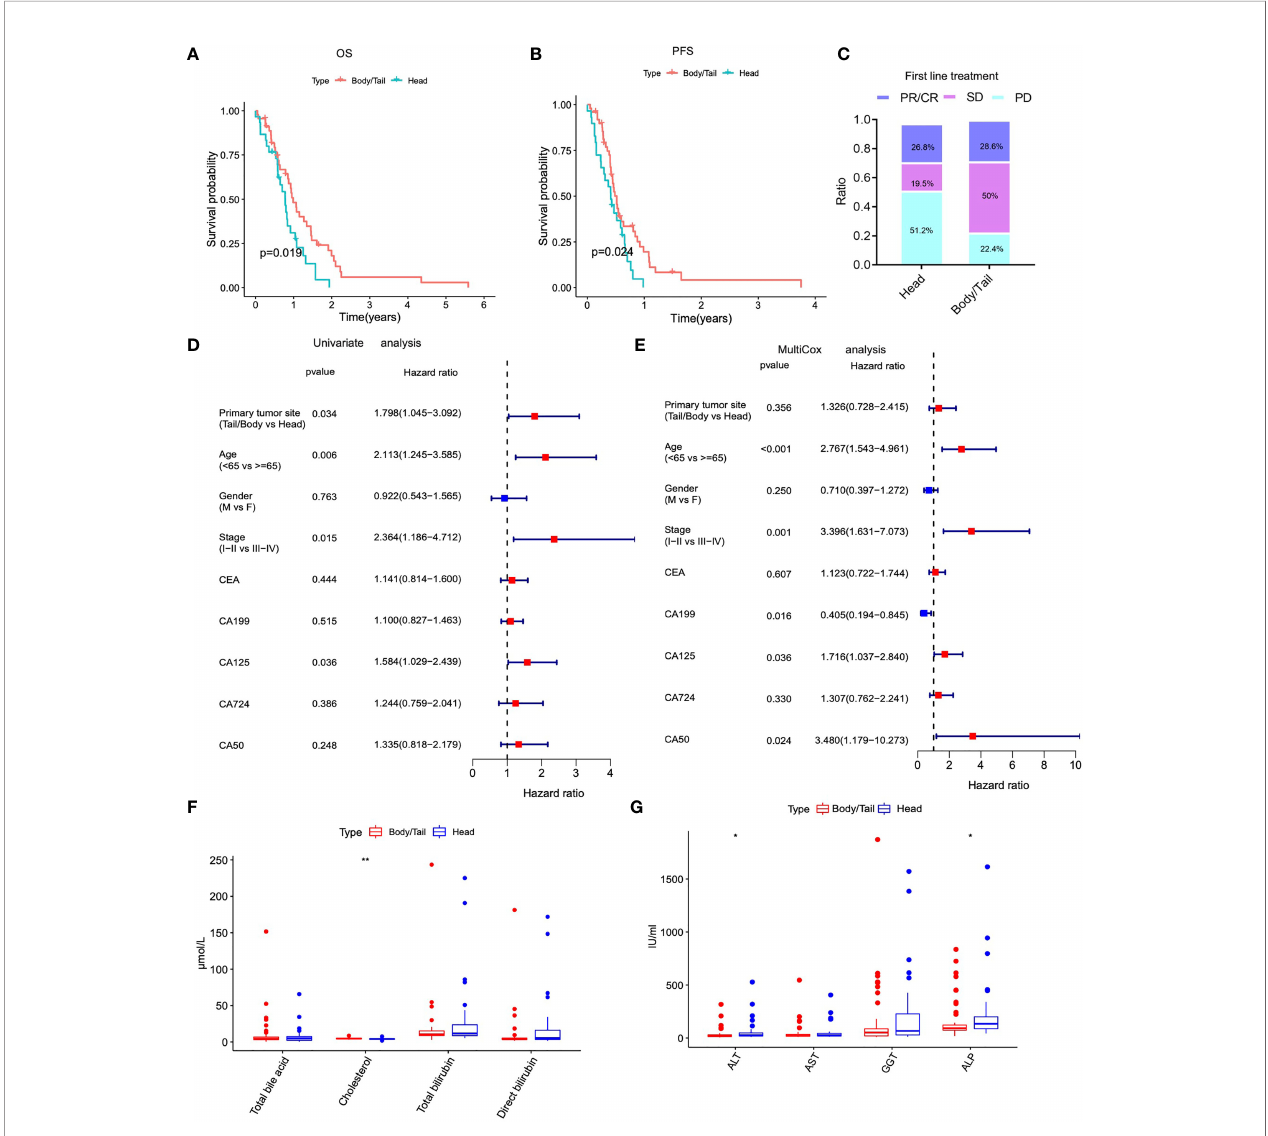
FIGURE 1 | The anatomical location of PAAD was closely related to clinicopathological characteristics and outcomes of initial therapy. (A) Kaplan – Meier analysis showed that patients of pancreatic head cancers exhibited worse OS. (B) Kaplan-Meier (K-M) survival analysis showed that patients of pancreatic head cancer exhibited worse PFS. (C) The ORR of worse outcomes after fi rst line treatment was greatly elevated in pancreatic head cancer group. (D) Univariate cox regression analysis demonstrated that primary tumor site was an independent risk factor for OS. (E) Multivariate cox regression analysis demonstrated that primary tumor site was an independent risk factor for OS. (F – G) The levels of important biochemical indexes of peripheral blood between pancreatic head cancer group and pancreatic body/tail cancer group in our institution ’ s data. PAAD, pancreatic adenocarcinoma; OS, overall survival; PFS, progression free survival; ORR: objective response rate; PD, progressive disease; PR, partial remission, SD, stable disease; HR, hazard ratio; **p < 0.01, *p < 0.05 and not signi fi cant (p < 0.05) by repeated measures with Wilcoxon